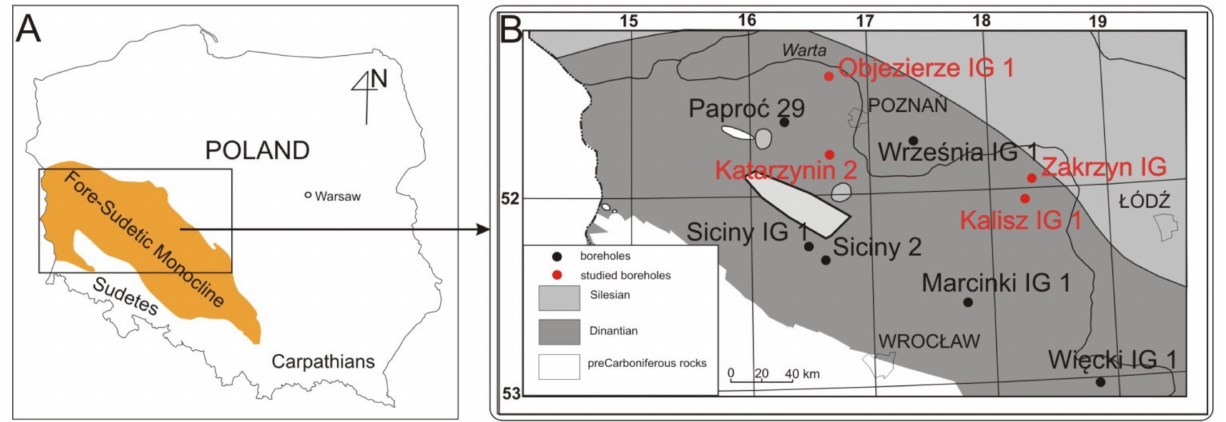
Figure 1. ( A ) The location of Fore-Sudetic Monocline; ( B ) A map of the top of the Carboniferous (according to [29]) with the locations of the studied